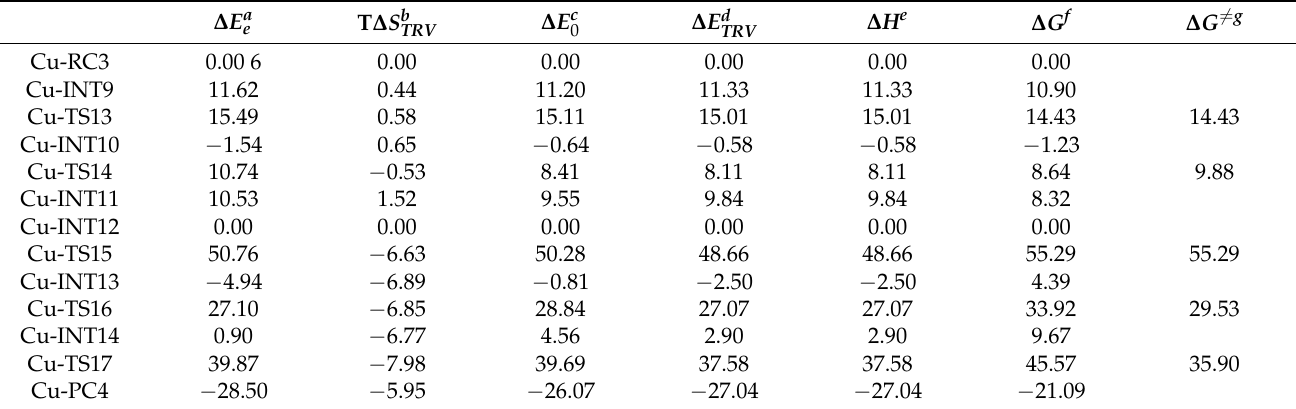
Table 4. Relative energies (in kcal/mol) with respect to the reactant complex (RC) for the catalytic hydrolysis of HCN with Cu-ZSM-5 in the gas phase of path D at the B3LYP/6–31++G (d,p)